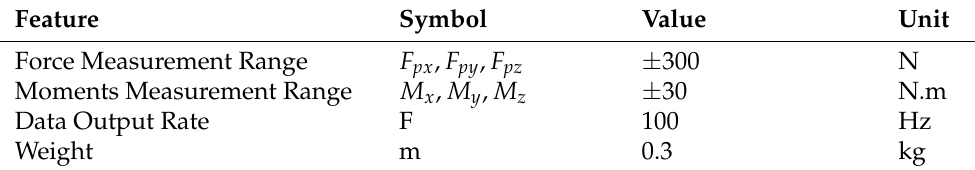
Table 1. Robotiq FT300 Force/Torque sensor characteristics [41].